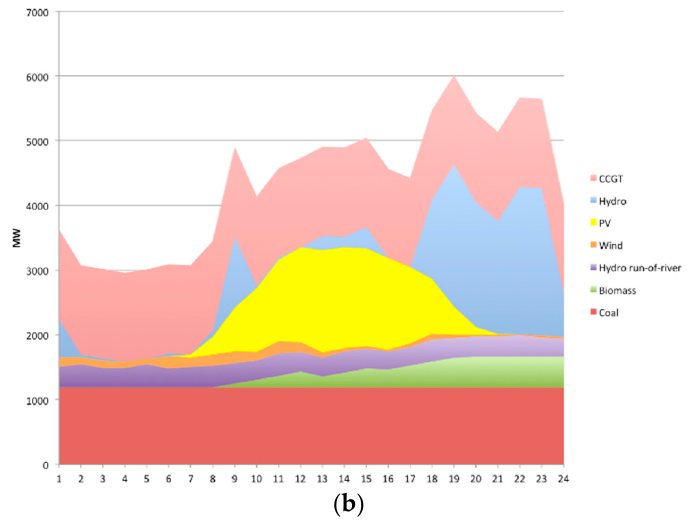
Figure 6. Generation profile—CSUD ( a ) winter and ( b ) summer.